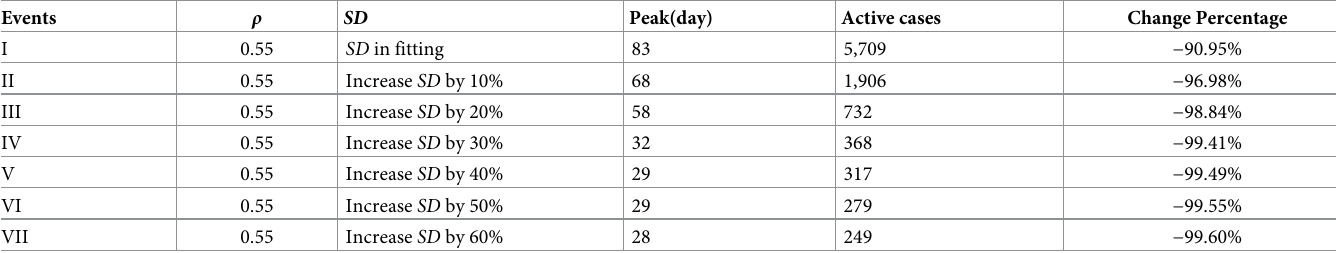
Table 14. Results of different scenarios Second Case, 4 th